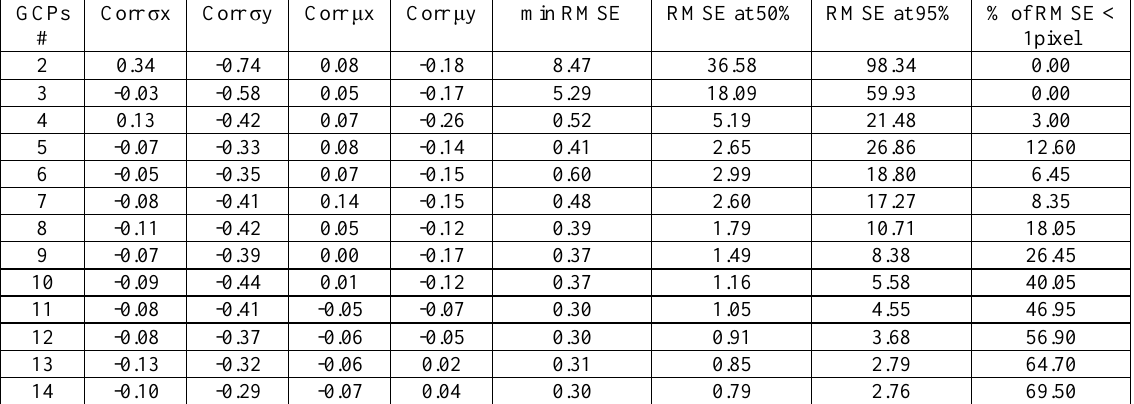
Table 5. The correlation between GCPs distribution and the resulting accuracy using different GCPs number